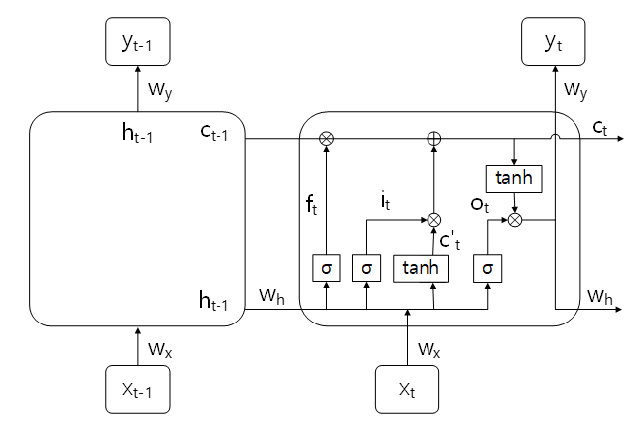
Figure 6. Schematic representation of long short-term memory (LSTM) model.